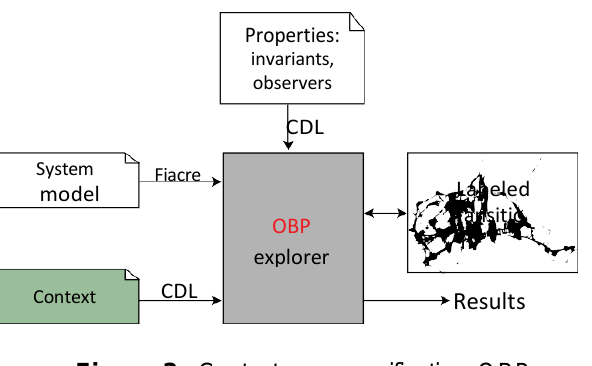
Figure 2. Context-aware verification: OBP Observation Engine